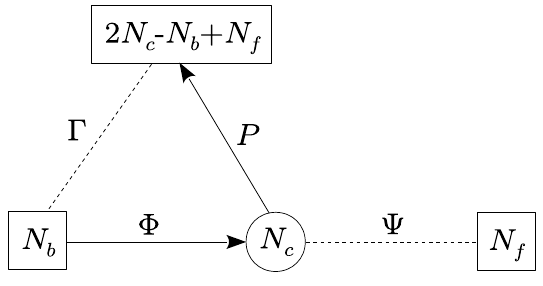
Figure 1 . The (cid:12)eld content of (0 ; 2) SQCD with SU( N c ) gauge group, N f (resp. N b ) Fermi (resp. chiral) multiplets in the fundamental representation, and 2 N c (cid:0) N b + N f chiral multiplets in the anti-fundamental representation. A similar theory with U( N c ) gauge group requires two extra Fermi multiplets in the determinant representation to cancel the abelian gauge